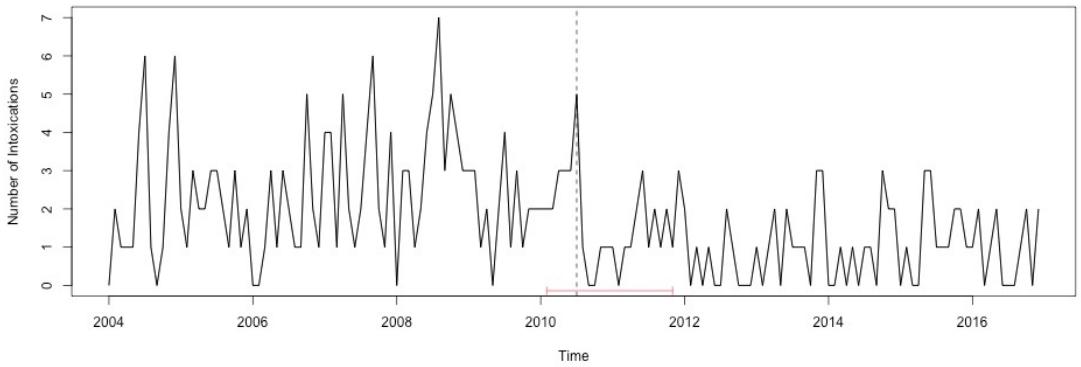
Figure A51. Methamphetamine intoxications 2004–2016 in the Czech Republic and structural breaks.